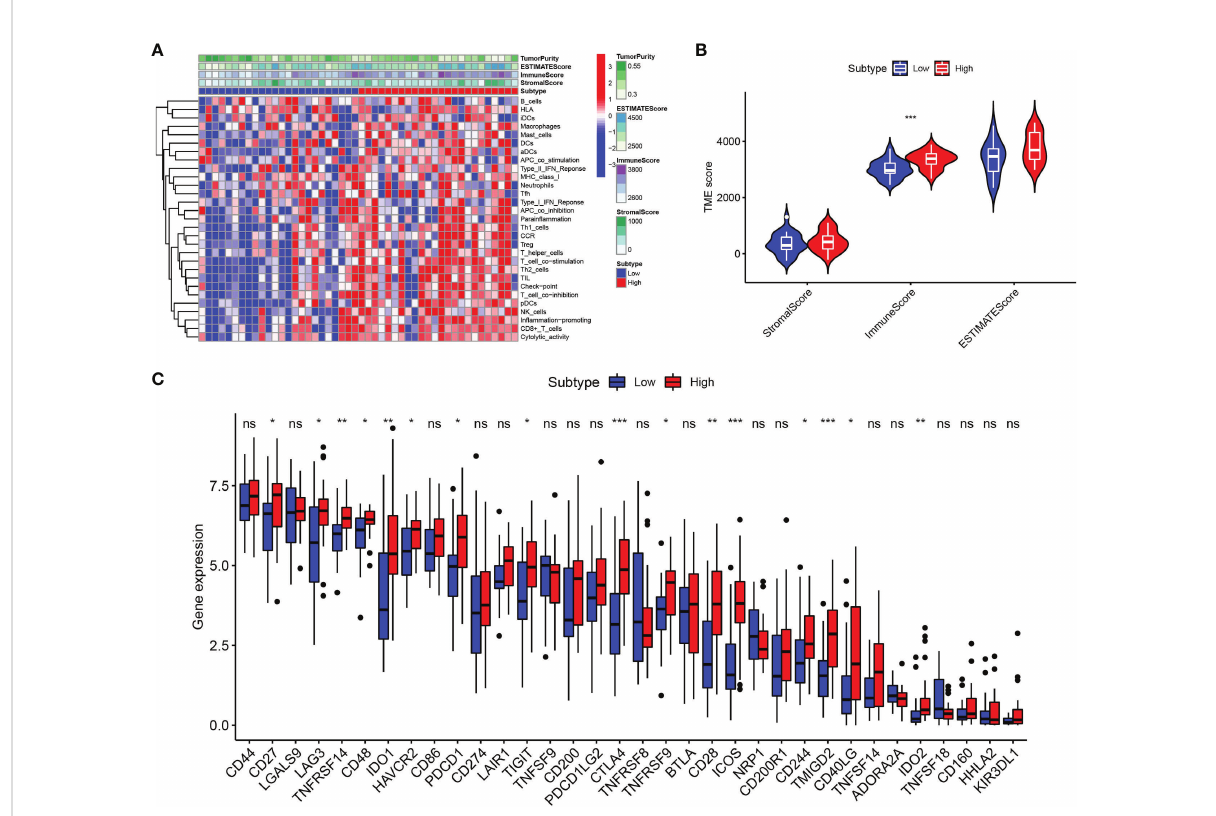
FIGURE 7 Immune microenvironment analysis in DLBCL patients with high and low LGALS2 expression. (A) Heatmap of the immune cells between high and low expression groups; (B) Comparison of ESTIMATE Score, Stromal score, and Immune score between LGALS2-high and LGALS2-low groups using the ssGSEA algorithm; (C) immune checkpoints between LGALS2-high and LGALS2-low groups. ssGSEA, single-sample Gene Set Enrichment Analysis. ns, no signi fi cance, * P < 0.05, ** P < 0.01, and *** P <